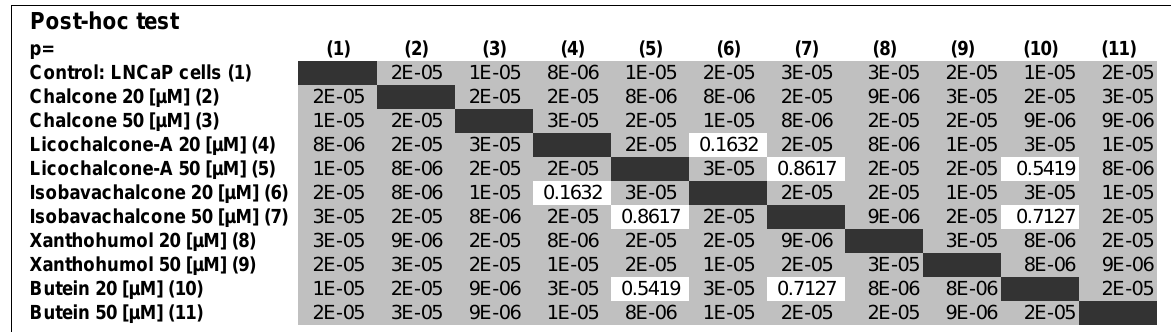
Table 1. Apoptosis induced by chalcones - p